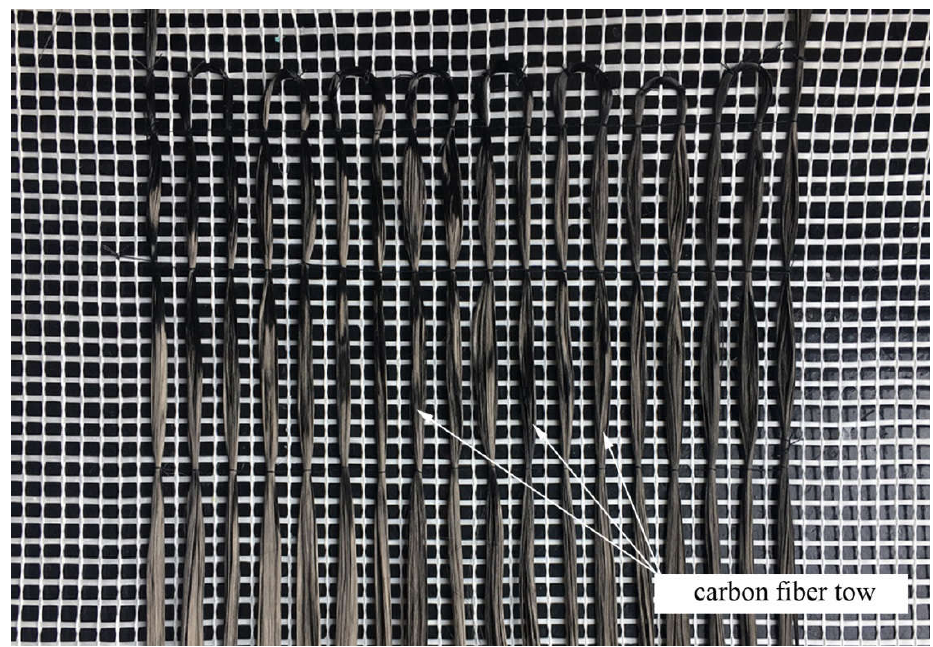
Figure 2. The third generation of the textile sensor during fabrication.